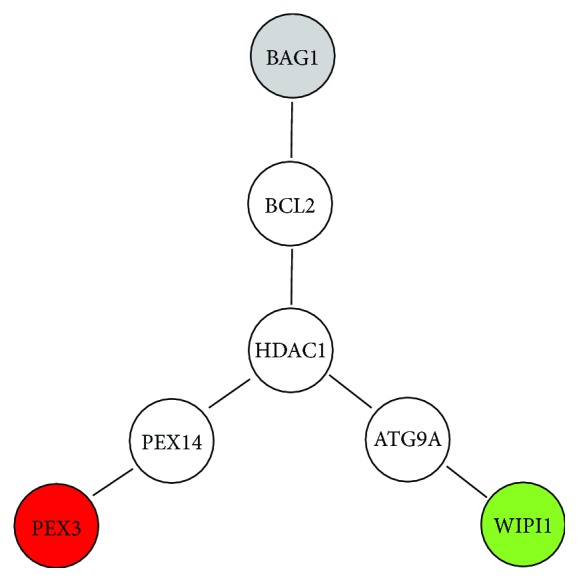
STRING analysis of WIPI1, BAG1, and PEX3 network. BCL2, PEX14, and ATG9A physically/functionally connect BAG1, PEX3, and WIPI1 (respectively) via HDAC1.